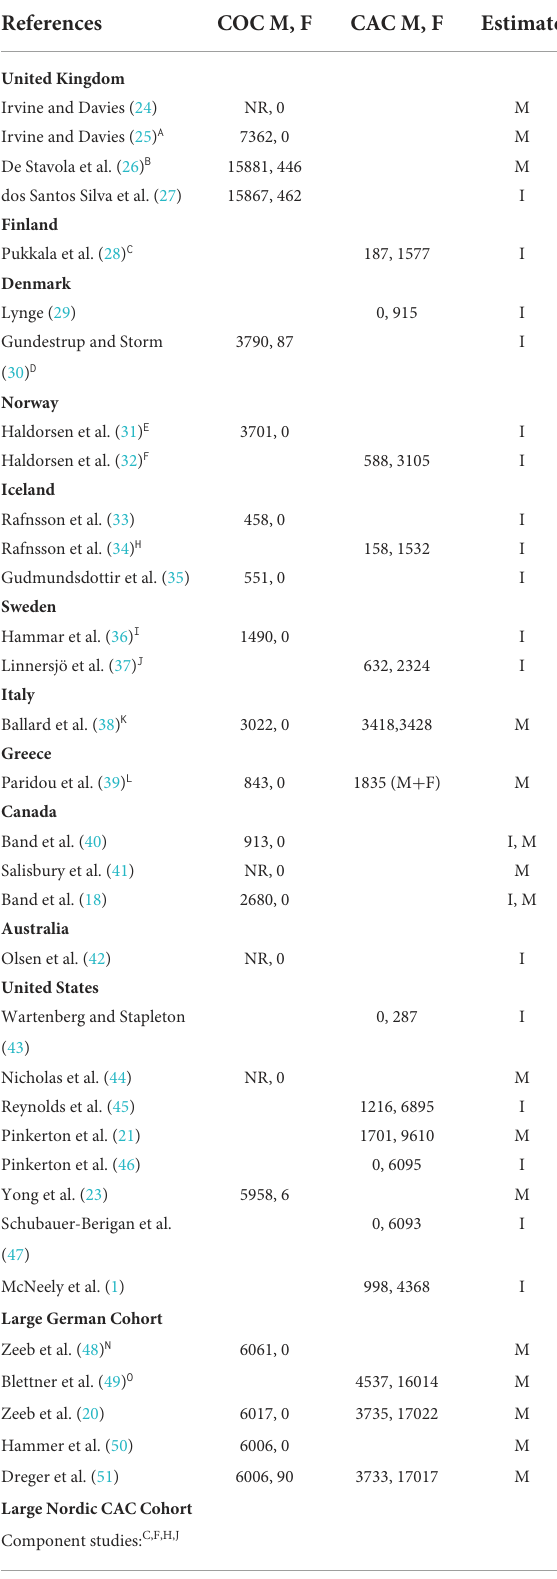
TABLE 1 Overview of CIR related cancer studies and